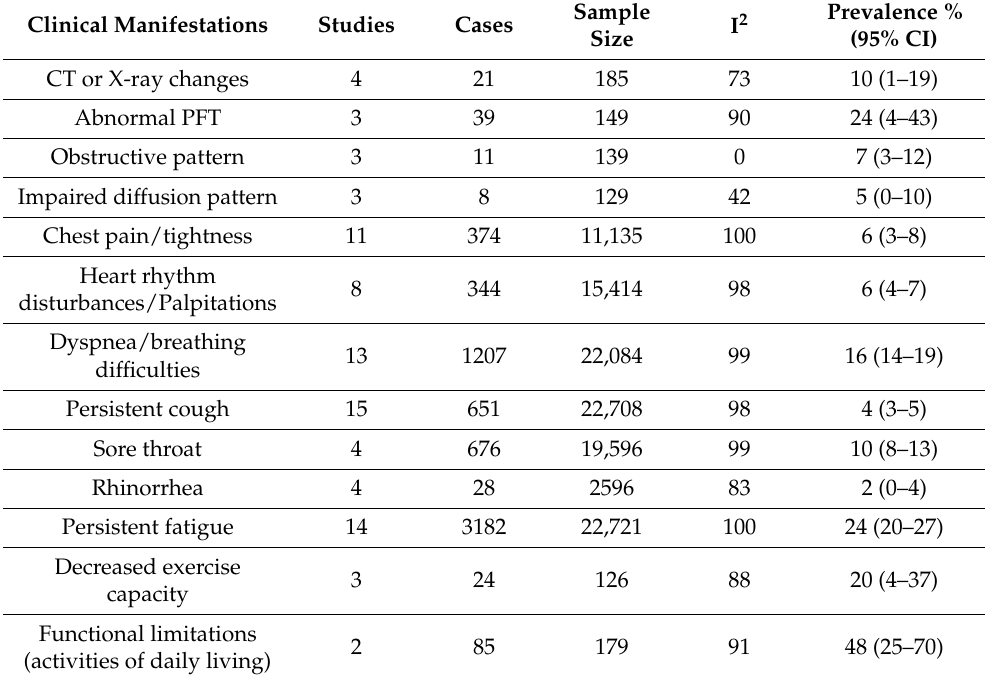
Table 2. Pooled prevalence of COVID symptoms in children and adolescents between 3- and 12- months post-